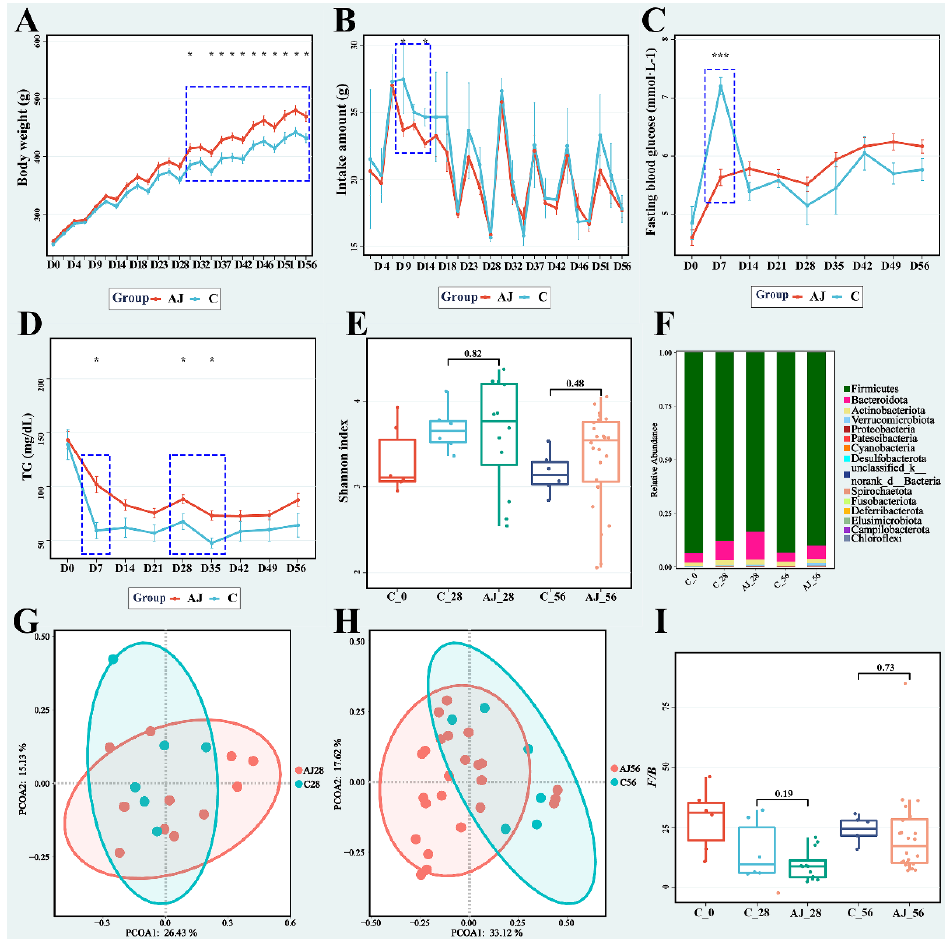
Figure 2. Effect of CAJ on rats: ( A ) Body weight. ( B ) Intake amount. ( C ) Fasting blood glucose. ( D ) Triglyceride content. ( E ) Shannon index. ( F ) Bar plot of gut microbiota on phylum level. ( G ) PCoA scores plot on OTU level of D28. ( H ) PCoA scores plot on OTU level of D56. ( I ) Box plot of F / B ratio. C, control group; AJ, apple juice groups, including NFC and FC groups. * indicates significant dif- ference ( p < 0.05) between CAJ and C groups. The “*” means p < 0.05, and “***” means p < 0.001. According to the α -diversity results shown in Figure 2E, no significant difference was observed between the groups at the same time point. Moreover, no obvious separation between the CAJ and C groups was observed in principal coordinate analysis (PCoA) score plots of β -diversity at the operational taxonomic unit (OTU) level on D28 and D56 (Figure 2G,H). In the gut microbiota at the phylum level, the dominant phyla were Firmic- utes and Bacteroidota , whose relative abundance was higher than 80.8% in all samples (Fig- ure 2F). According to numerous studies on gut microbiota and obesity, changes in the relative abundance of these two dominant bacteria, that is, an increase in Firmicutes and a decrease in Bacteroidota , can lead to an improvement in the host’s ability to obtain energy from foods, thus affecting the host’s energy balance and body weight [13]. This improve- ment may not immediately lead to obesity; however, a slight change in energy balance can cause significant changes in body weight over a long period [14,15]. Therefore, the ratio of Firmicutes to Bacteroidota could be a good biomarker for obesity [16]. As shown in Figure 2I, the ratio of the two dominant bacteria, Firmicutes / Bacteroidota ( F/B ), was not sig- nificantly different between groups at the same time point. Prolonged and continuous intake of CAJ may incrementally improve body weight, as revealed by the significantly higher body weight of the CAJ group. However, as the fasting blood glucose and F/B ratio